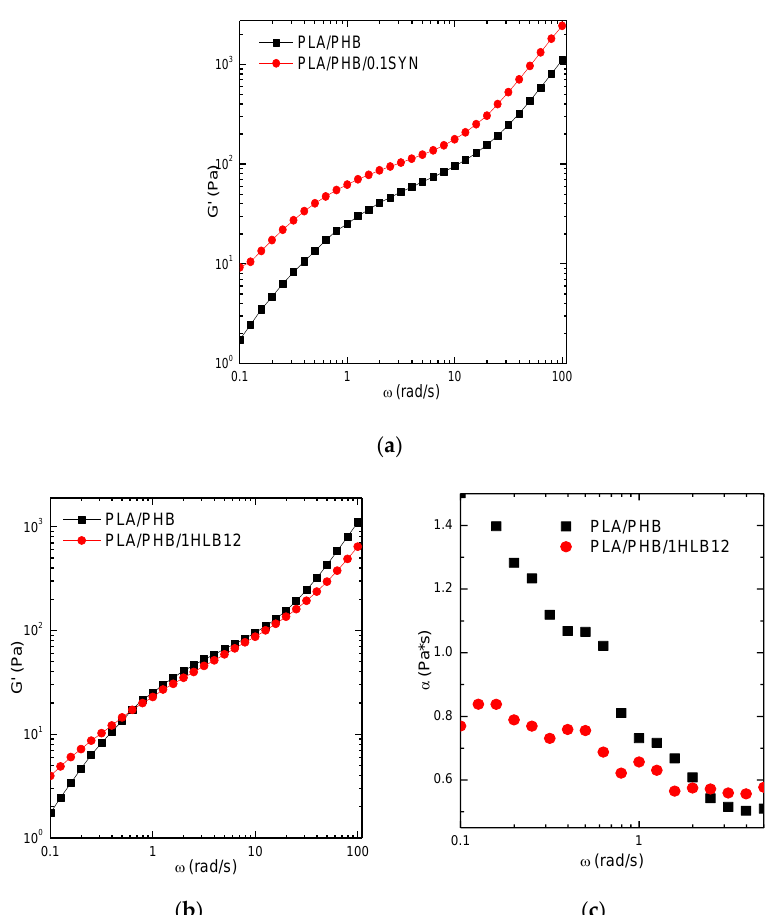
Figure 4. G’ curves for ( a ) PLA / PHB and PLA / PHB / 0.1SYN and ( b ) for PLA / PHB and PLA / PHB / 1HLB12, and ( c ) α as a function of frequency for PLA / PHB and PLA / PHB /